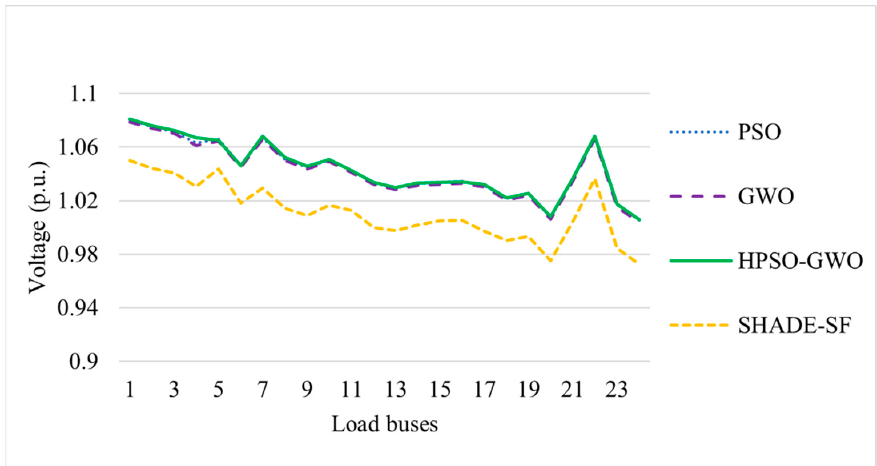
Figure 17. Load buses voltage profile comparison (Case